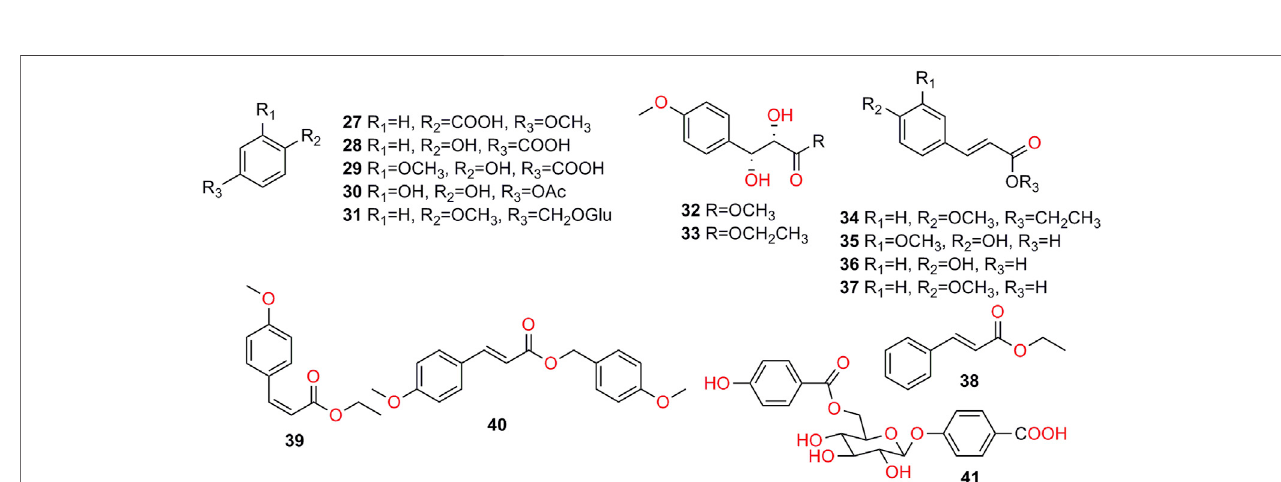
FIGURE 4 | Structures of phenolics isolated from K. galanga